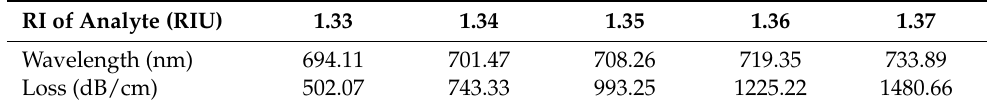
Table 1. Changes of loss peak with different refractive indexes of the